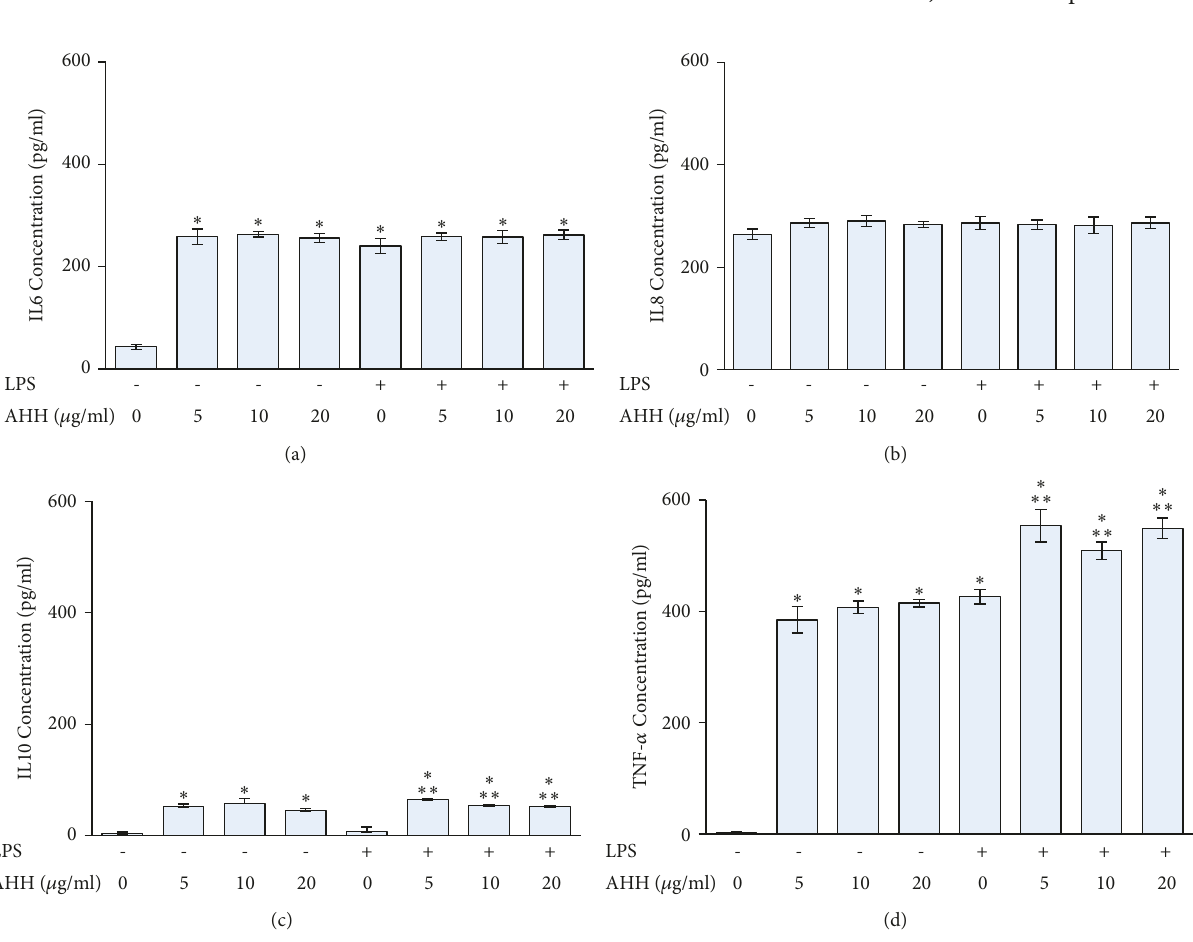
Figure 5: The effect of AHH on IL6 (a), IL8 (b), IL10 (c), and TNF- 𝛼 (d) production in PBMCs and LPS-treated PBMCs. PBMCs were separated using Ficoll-Paque density centrifugation, seeded in 12-well plates, and treated with 10 𝜇 g/ml LPS and AHH at the indicated concentrations for 24 h. The levels of IL6, IL8, IL10, and TNF- 𝛼 secretion were determined using ELISA with specific antibodies to each cytokine. ∗ p < 0.05 compared to control group; ∗∗ p < 0.05 compared to LPS-treated group